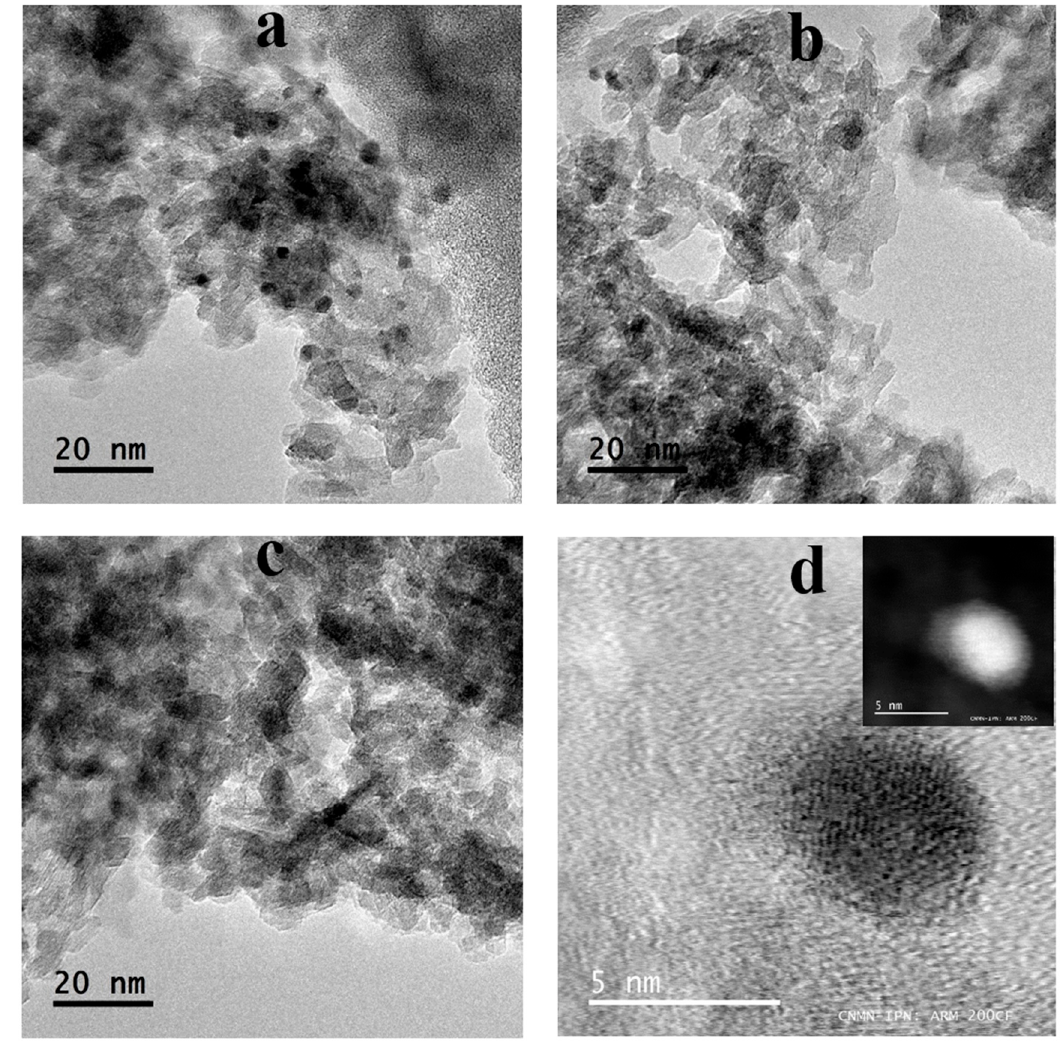
Figure 3. TEM micrographs of Ni/ γ -Al 2 O 3 catalysts: ( a ) NAL3; ( b ) NAL5; ( c ) NAL7; and ( d ) lattice fringes of Ni NPs on the NAL5 catalyst.